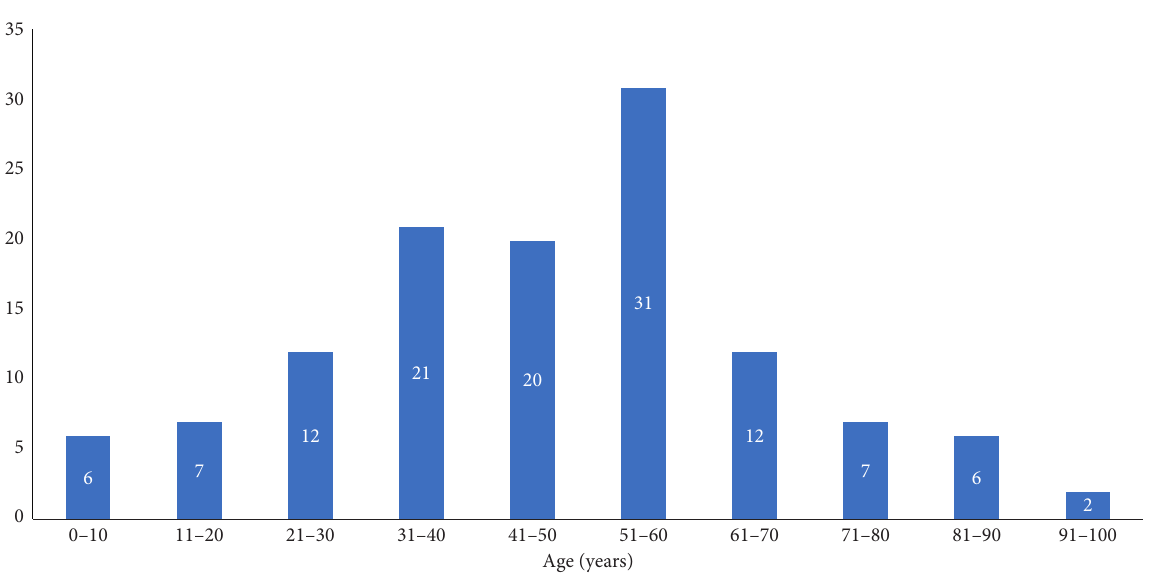
Figure 2: Age distribution of patients at the time of the enucleation/evisceration. Table 2: Associated preexisting ophthalmological factors, systemic diseases, and social factors at the time of ocular trauma for patients who underwent secondary enucleation or evisceration.